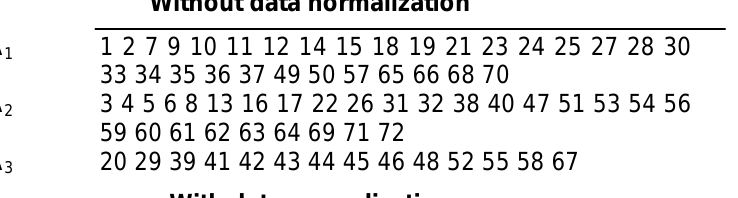
Results of Horizontal Fuzzy Clustering of the Cardiac Patients without and with Data Normalization, Considering only Seven Characteristics Cardiac patients Fuzzy class